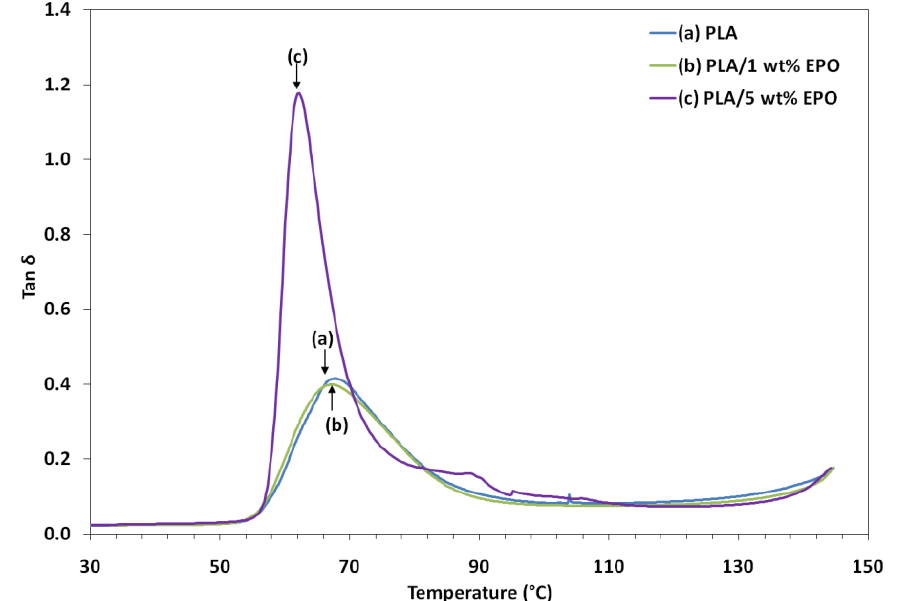
Figure 10. Loss factor of neat PLA and PLA/EPO blends as a function of